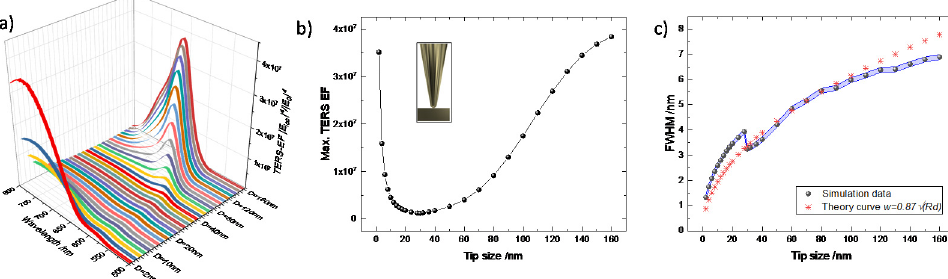
Figure 2. Simulation results of ( a ) the spectral dependence of the TERS EF, ( b ) max. TERS EF, and ( c ) full-width-at-half- maximum (FWHM) of the local TERS profile in the conventional gap-mode TERS geometry as shown in the inset of Figure 2b. The simulated FWHM as a function of the tip diameter is compared with the FWHM profile derived from Equation (3) (red asterisks in Figure 2c). The blue shaded area presents the error bar of the FWHM.